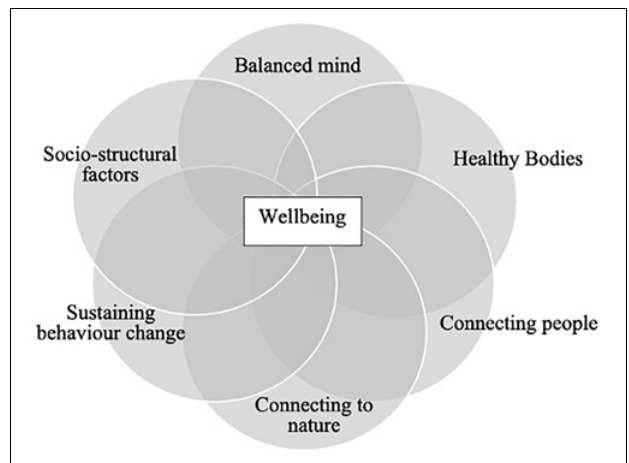
FIGURE 1 | Summary of the core components of our interventions, integrating insights from psychological science with developments across multiple disciplines spanning the individual, community and the